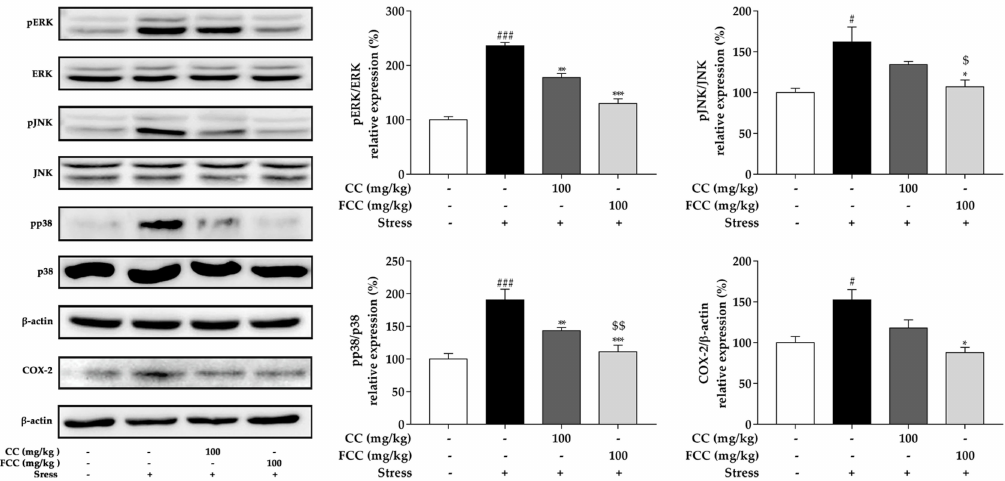
Figure 4. Neuroprotective of CC and FCC on stress-induced hippocampal deficits in rats by modulating mitogen-activated protein kinases (MAPK) (ERK, JNK, and p38) and COX-2 signaling pathway. The expressions of phosphorylation MAPK and COX-2 were evaluated by western blotting. “ + , -”: Rats were treated with or without CC extract, FCC extract or stress. The data are expressed as mean ± SD, n = 8. # p < 0.05, ### p < 0.001, compared to the control group and * p < 0.05, ** p < 0.01, *** p < 0.001 compared to stress alone group, and $ p < 0.05, $$ p < 0.01 compared to CC 100